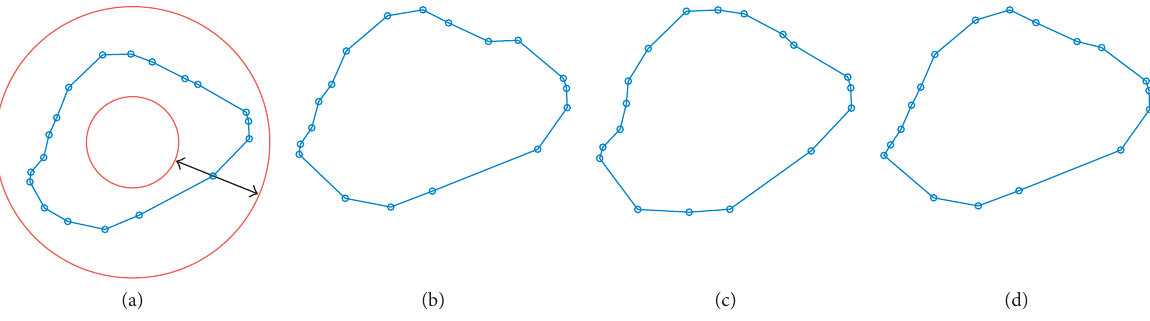
Figure 3: Control points random movement. (a) Annular band. (b) New aggregate 1. (c) New aggregate 2. (d) New aggregate